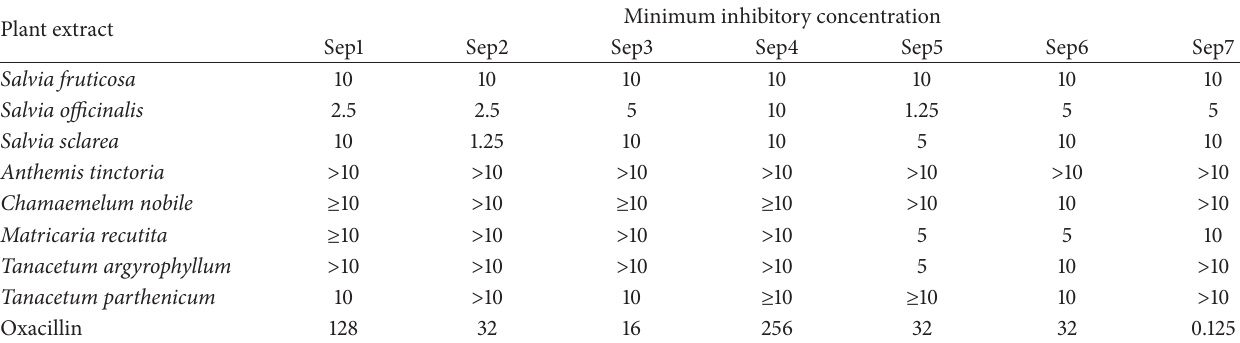
Table 2: Minimum inhibition concentration (MIC) of plant extracts and oxacillin established by both microdilution method. MIC is given as % (v/v) for plant extracts and mg/L for